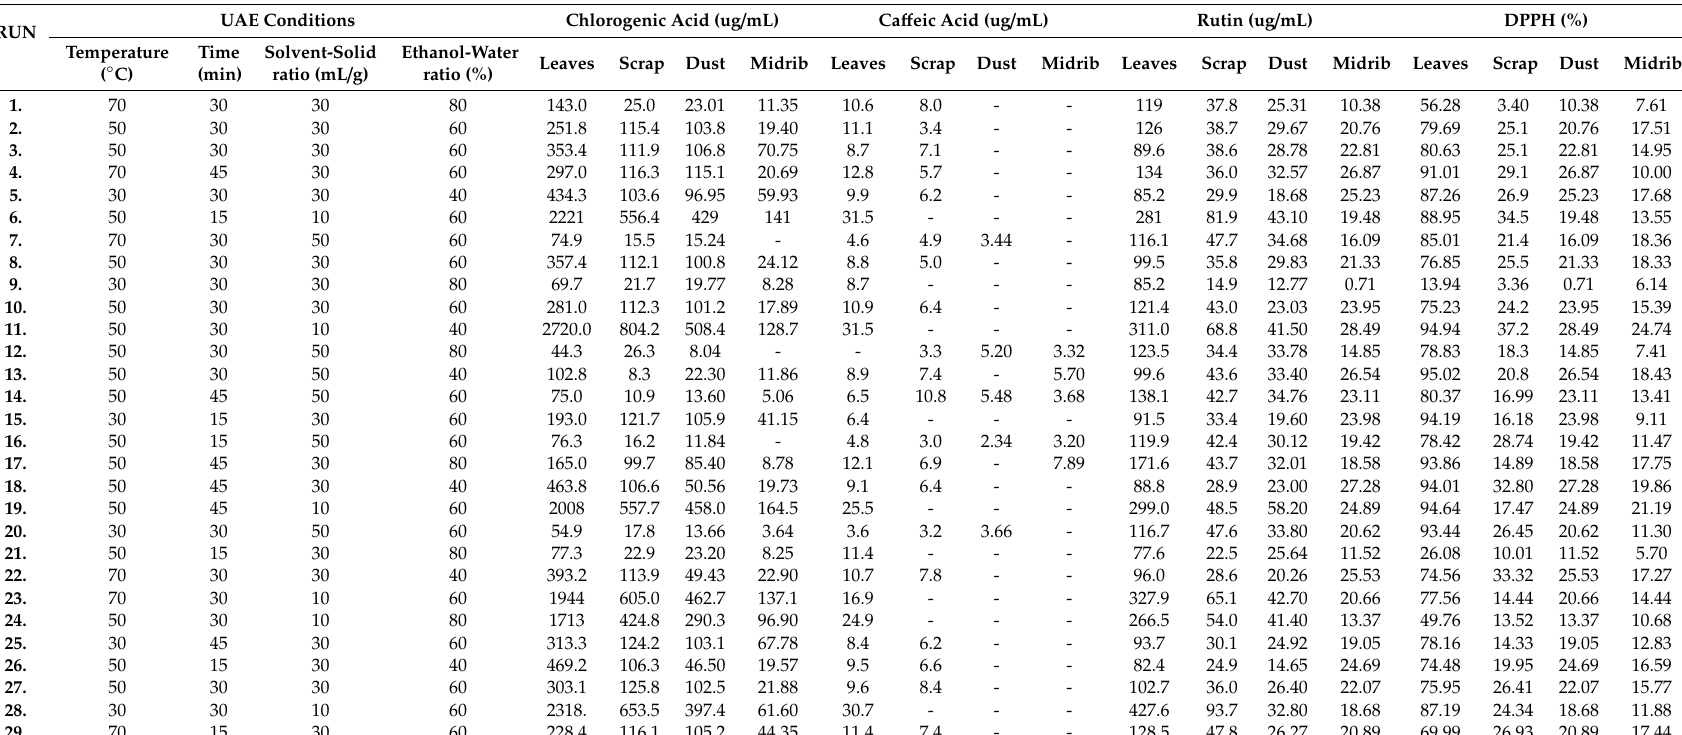
Table 2. Detected phenolic compounds in tobacco extracts and its antioxidant